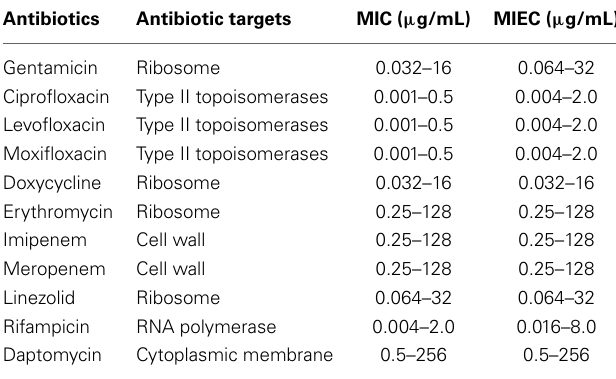
Table 1 | Ranges of antibiotic concentrations tested for determination of MICs (broth microdilution method) and MIECs (dye uptake assay) for 11 antibiotics against Francisella tularensis subsp. holarctica